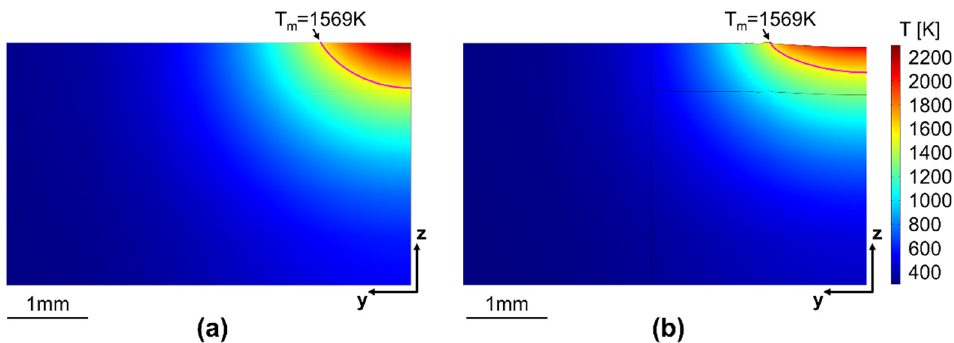
Figure 12. Temperature fields within the model domain and isothermal curves at remelting temperature T m calculated by ( a ) the heat conduction and ( b ) the fluid flow model for P = 1000 W, v = 400 mm/min, T = 20 °C.